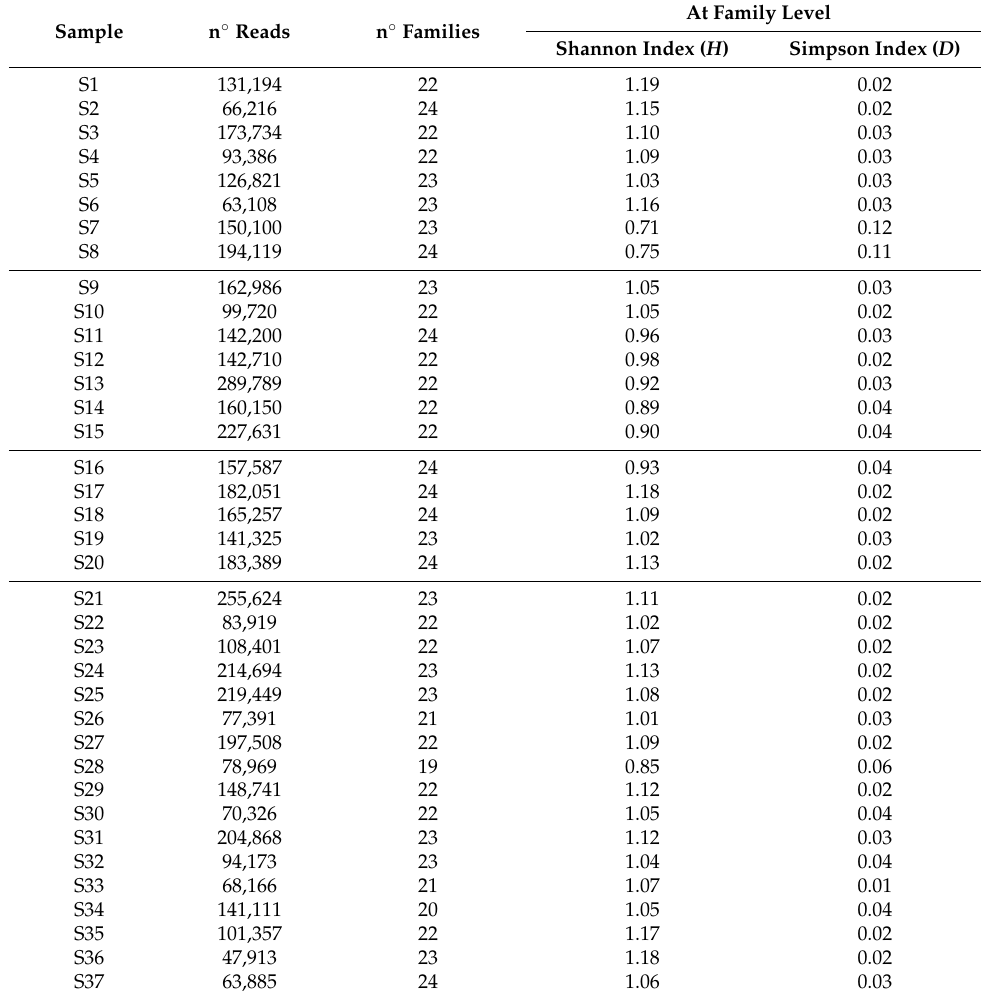
Table 4. Number of Streptophyta reads (also considering the Unclassified contribution) and families for the 37 PM10 samples collected in Lecce. Shannon and Simpson indices at the family level are also reported. Samples were collected in different seasons (winter: S1–S8, spring: S9–S15, summer: S16–S20, and autumn: S21–S37). Samples are listed according to the sampling month by taking as S1 the sample collected on 7 January